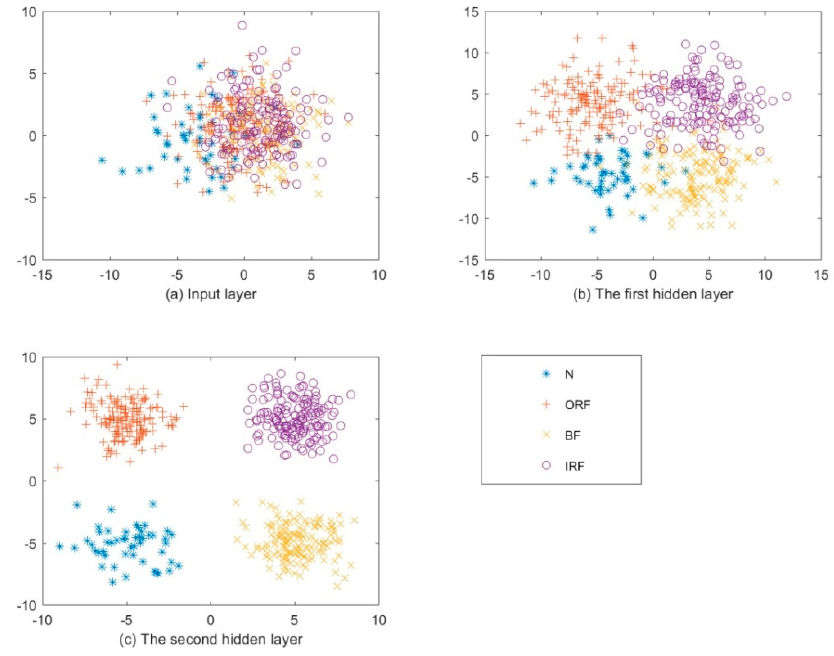
Figure 20. Visualization results of each layer.